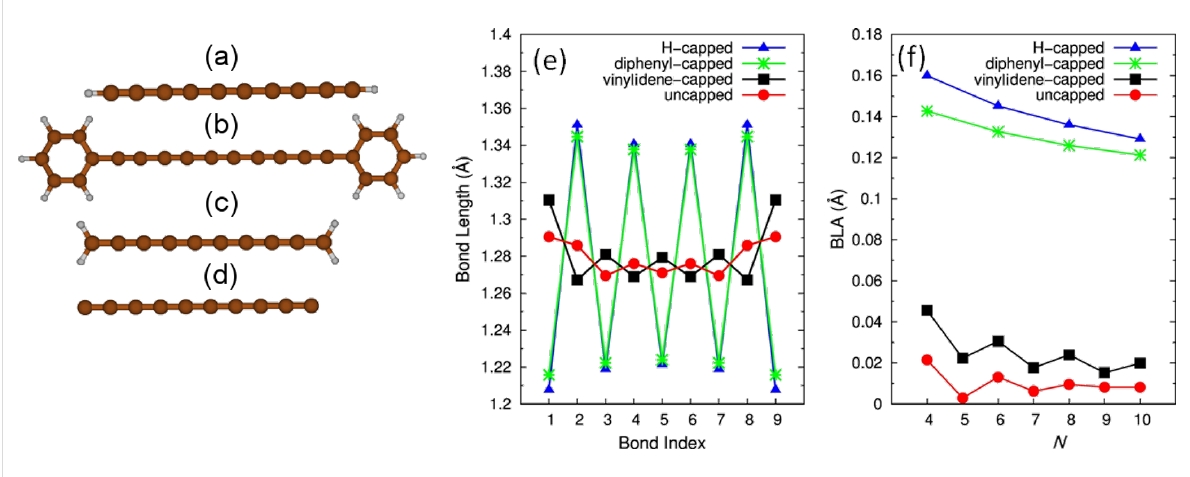
Figure 2: (a–d) carbon-atom wires with different terminations: hydrogen-capped (a), phenyl-capped (b), vinylidene-capped (c) and uncapped (d). The bond length and the bond length alternation (BLA) as a function of the number of carbon atoms comprising the wire are reported in panels (e) and (f), respectively. The data are from DFT